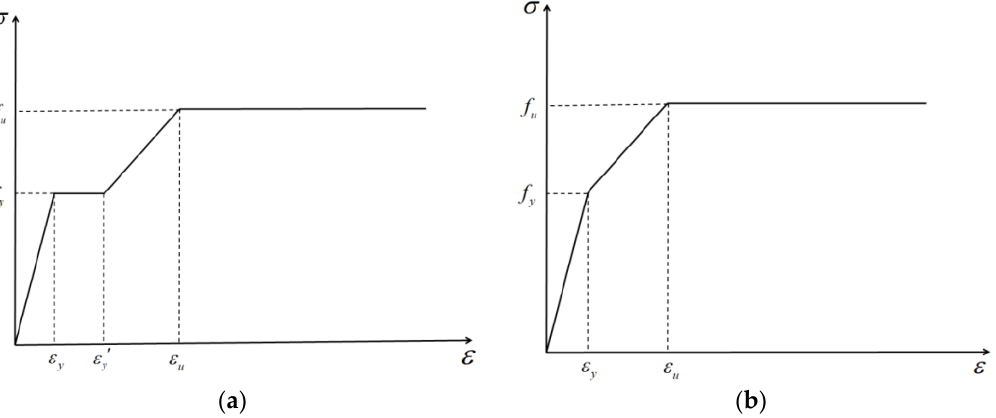
Figure 10. T-stub finite element model.